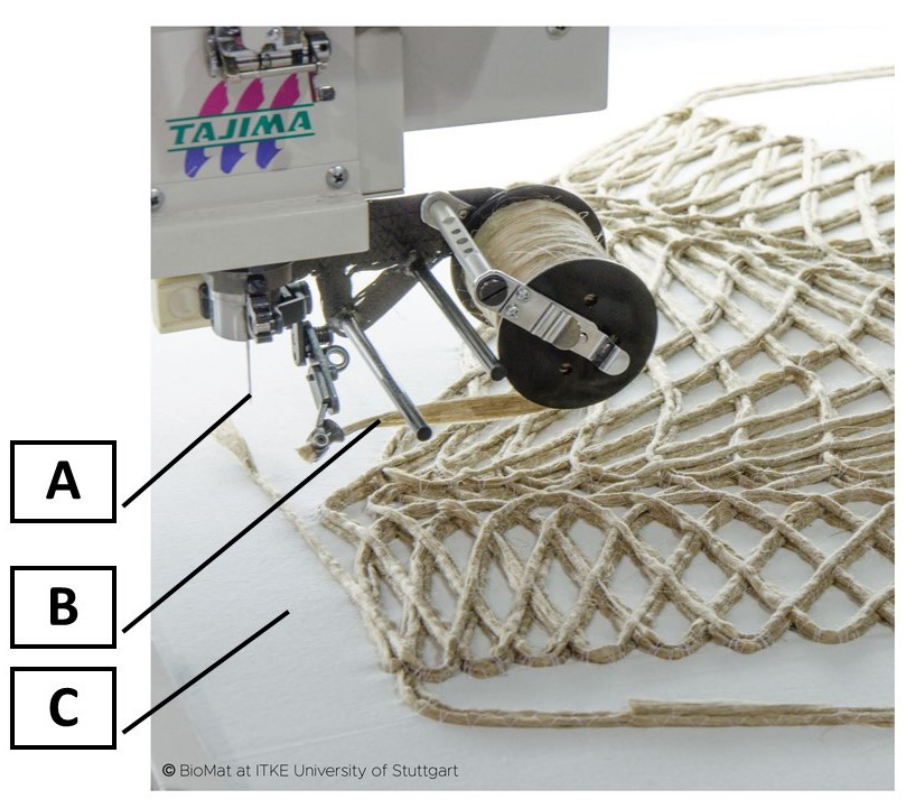
Figure 23. TFP machine layout. ( A ) Embroidery Needle ( B ) Flax Fibre ( C ) Glass fibre